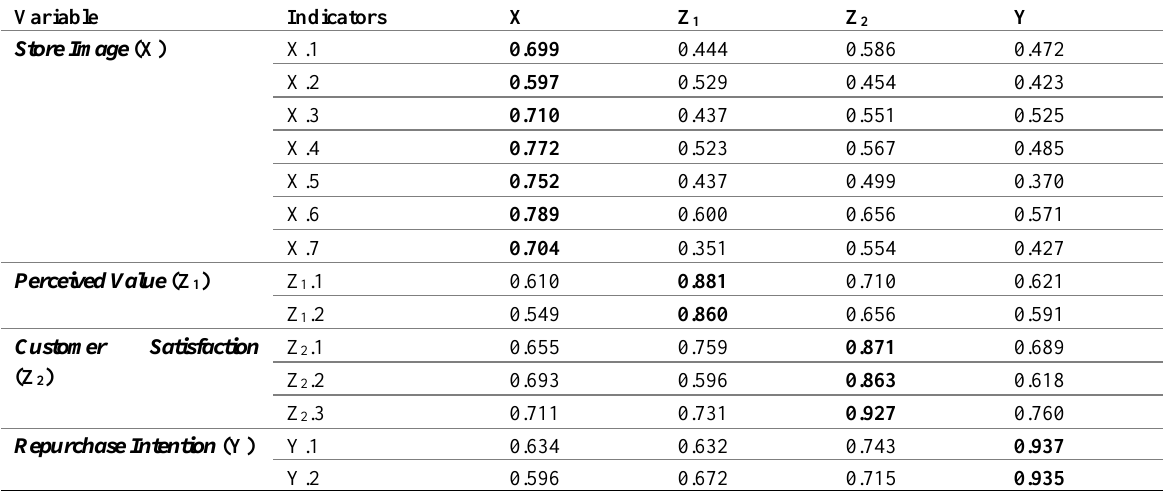
Table 2: Discriminant Validity Using Cross Loading